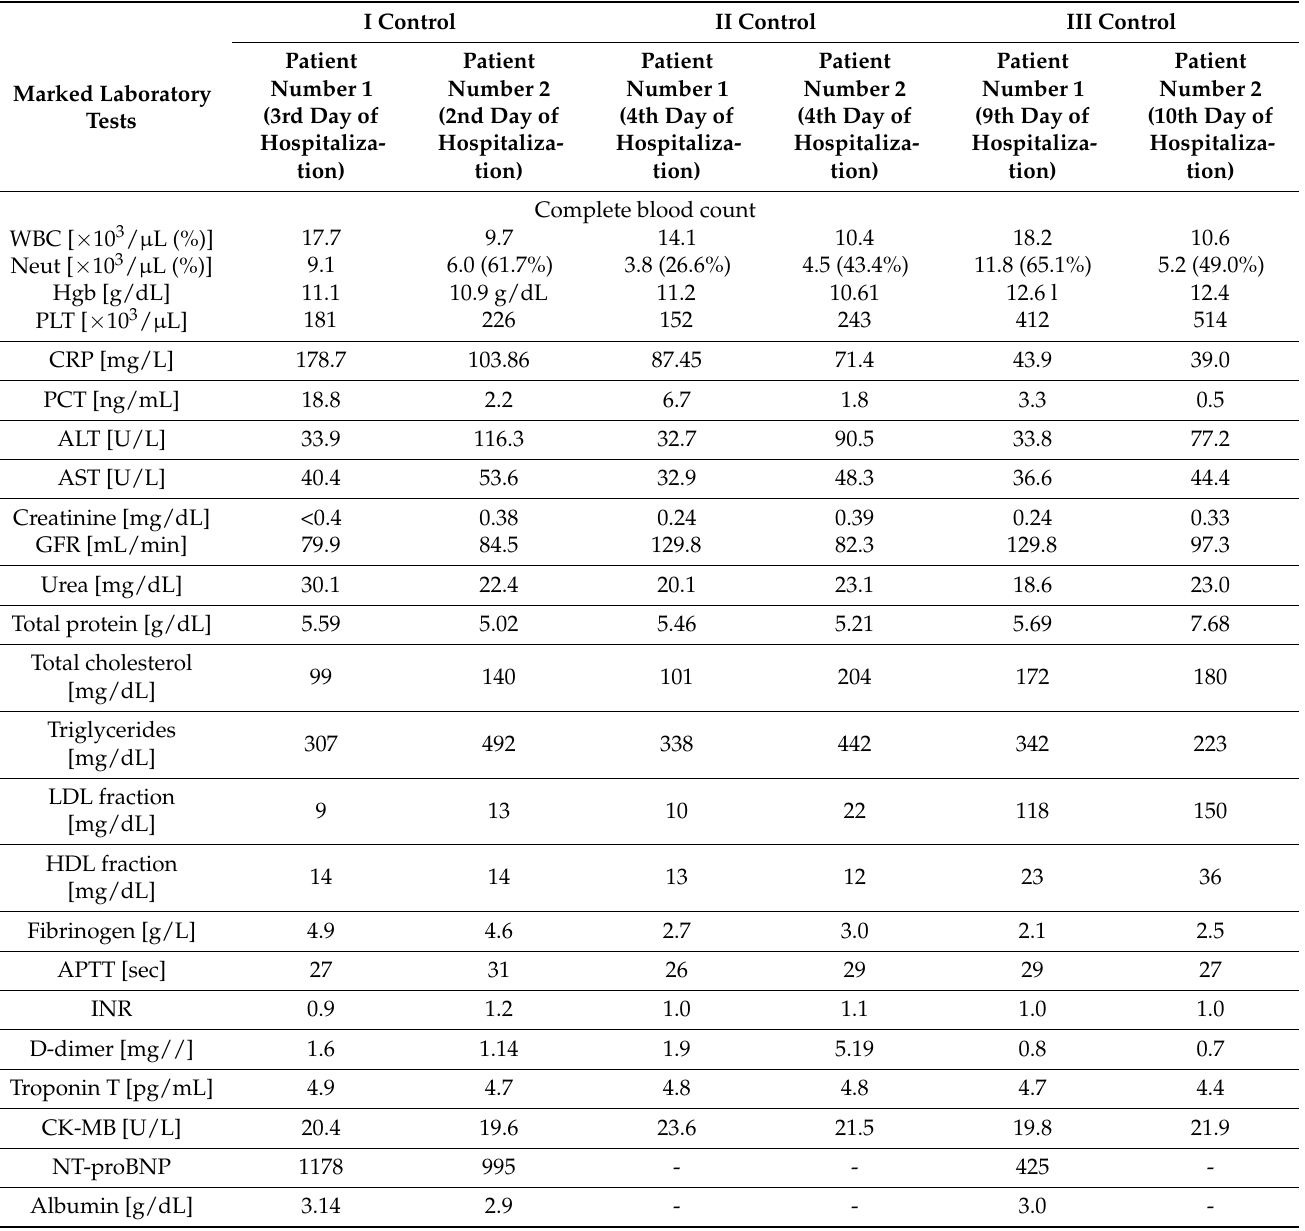
Table 2. Diagnostics during hospitalization in the Department of